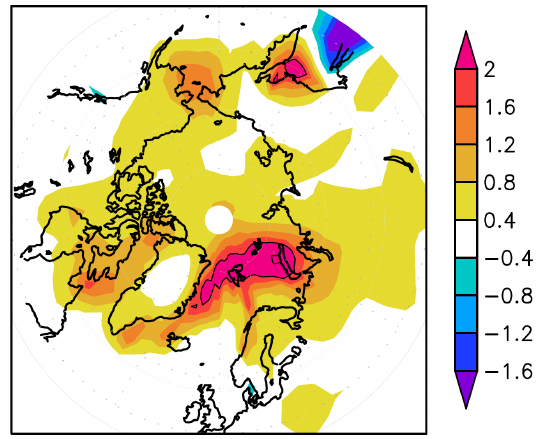
Fig. 5. Cold season (November–April) ensemble mean SAT dif- ferences ( ◦ C) averaged over the period 1989–2008 between the HadISST and HadISST-fixed sea ice